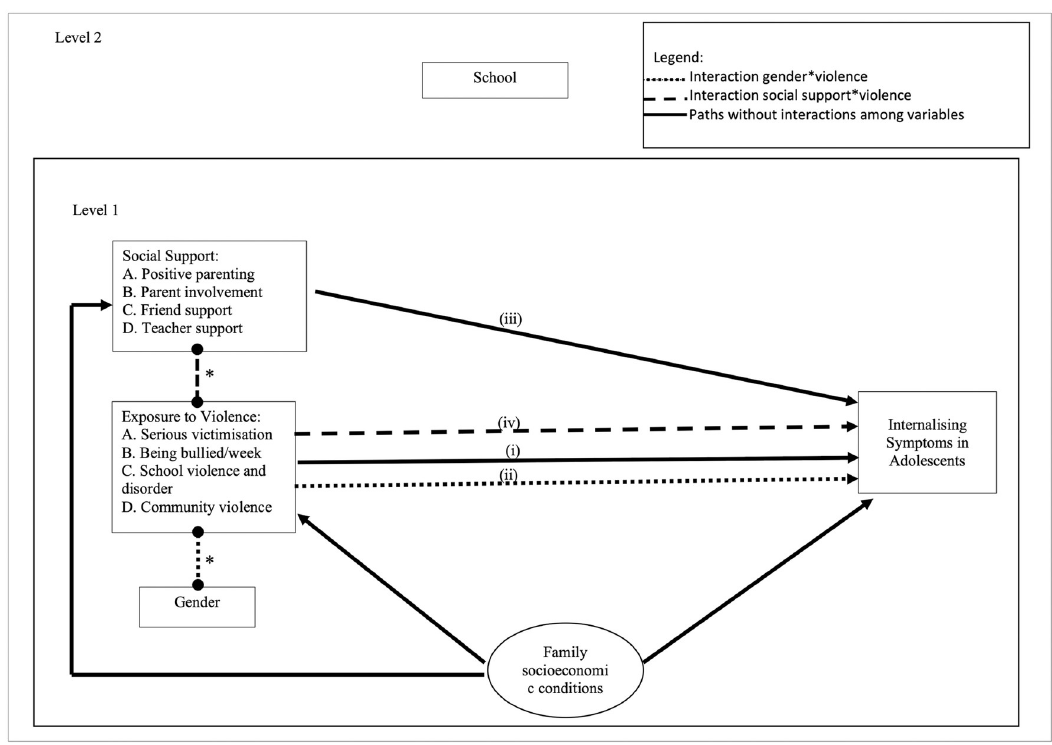
Fig 1. Model of exposure to violence, social support, internalising symptoms, and